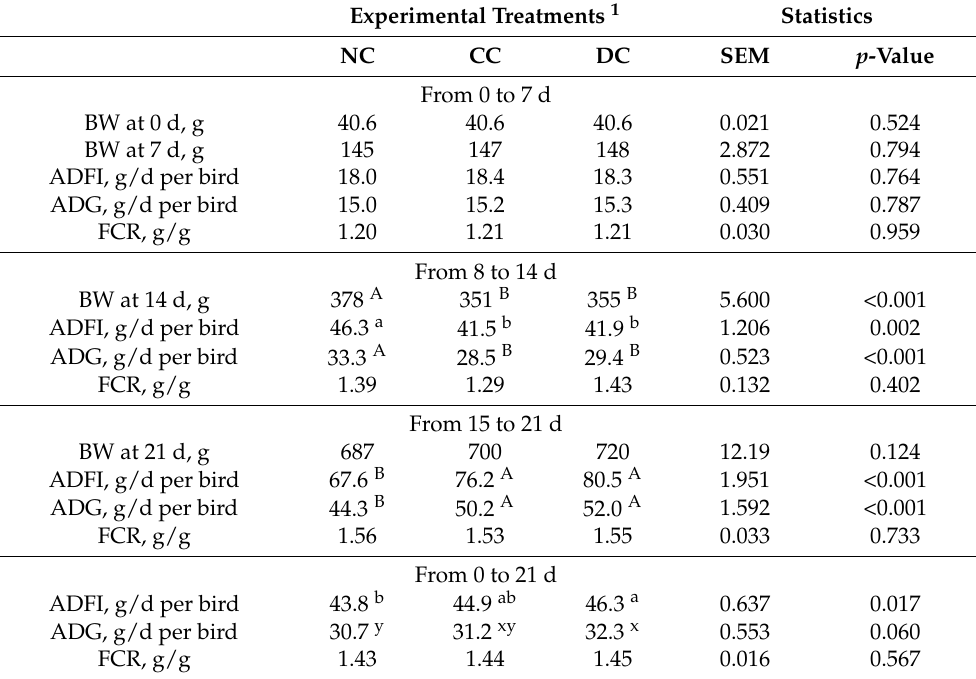
Table 8. Effects of treatments on growth performance of broiler chickens challenged with coccidiosis (Experiment 2).